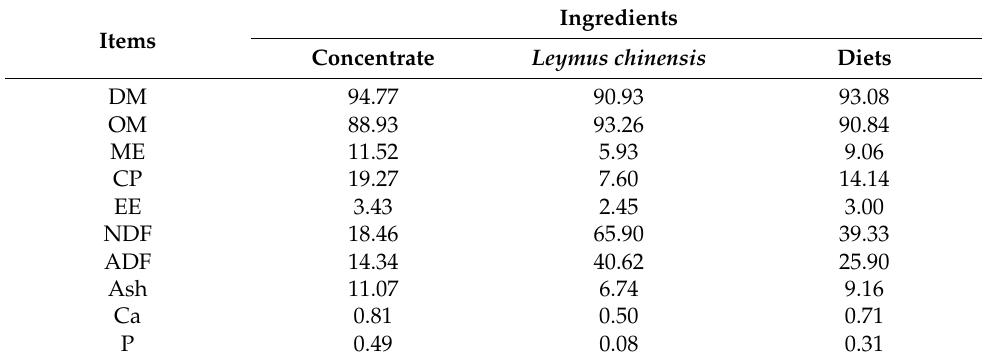
Table 3. The composition and nutrient levels of diets (%, dry